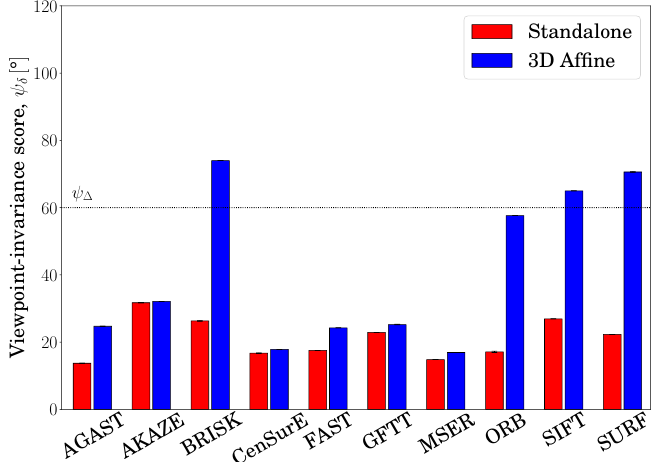
Figure 12. Viewpoint invariance for each detector intermixed with the SIFT [19] descriptor. Ten different detectors were evaluated. The three that exceed the targeted viewpoint invariance, ψ ∆ , as denoted by the dotted horizontal line, were wrapped in the proposed embedding, represented by the blue bars. On the other hand, none of the standalone features approached the goal, as their red bars indicate. This figure utilizes the data from the ‘C. T. Crunch’ dataset observed from the NP3 camera. More extensive results are presented in later parts of Section